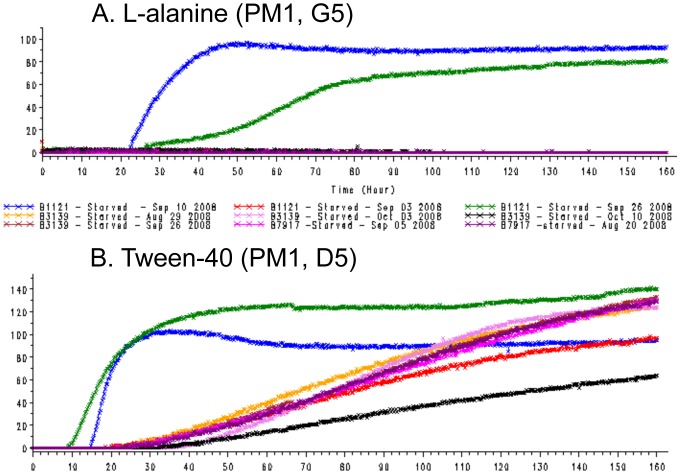
Dye reduction follows growth by M. bovis type 17 in Tween-40 but is only seen in contaminated wells in L-alanine.Omnilog units (arbitrary colour units due to dye reduction) were plotted against time (0 to 168 h). Colour coding for replicates is the same in both plots; blue and green plots were of data considered to be from contaminated inocula.